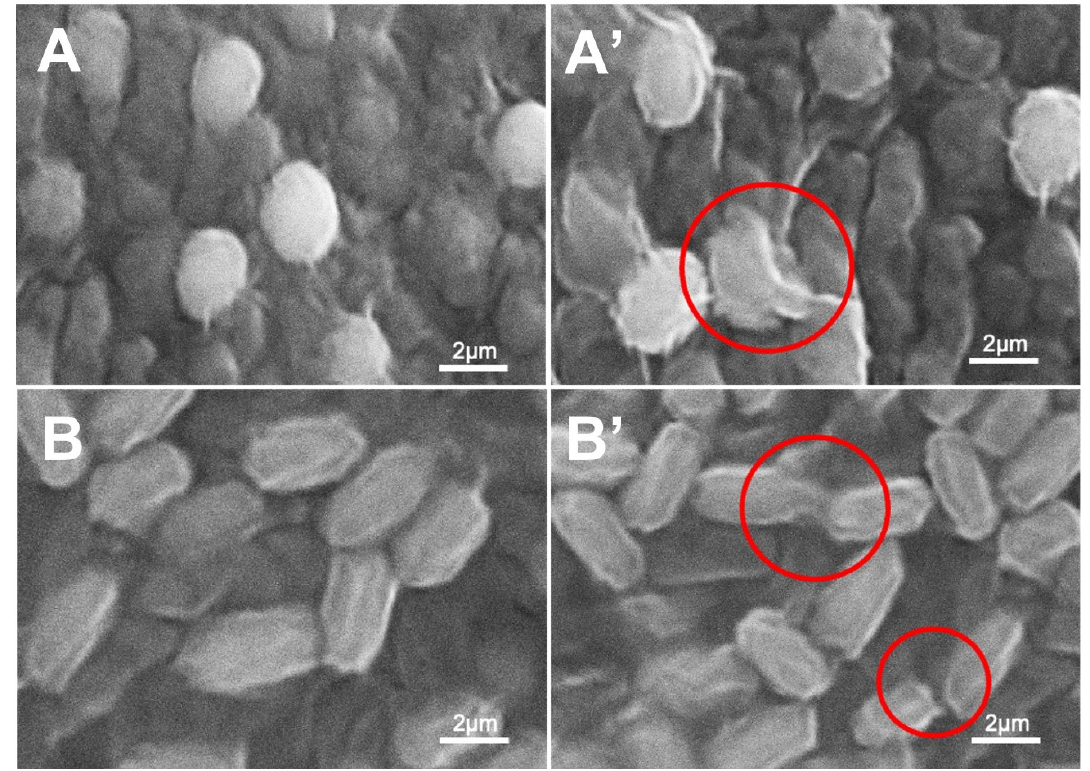
Figure 6. SEM images of ( A ) untreated and ( A’ ) treated S. aureus ; ( B ) untreated and ( B’ ) treated P. aeruginosa . Treated cells were exposed to protonated PANI fabric. Red circles indicate cell mem- brane